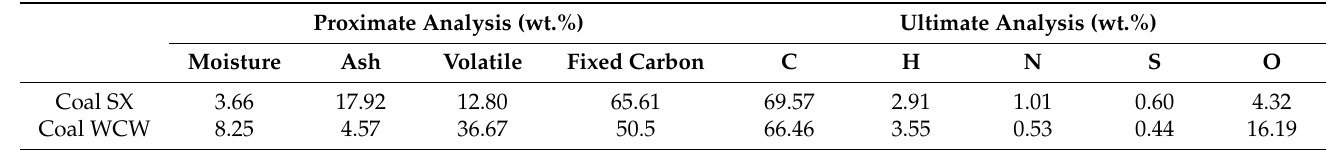
Table 1. Proximate analysis and ultimate analysis of coals Shanxi (SX) and Wucaiwan (WCW) (air-dried basis).